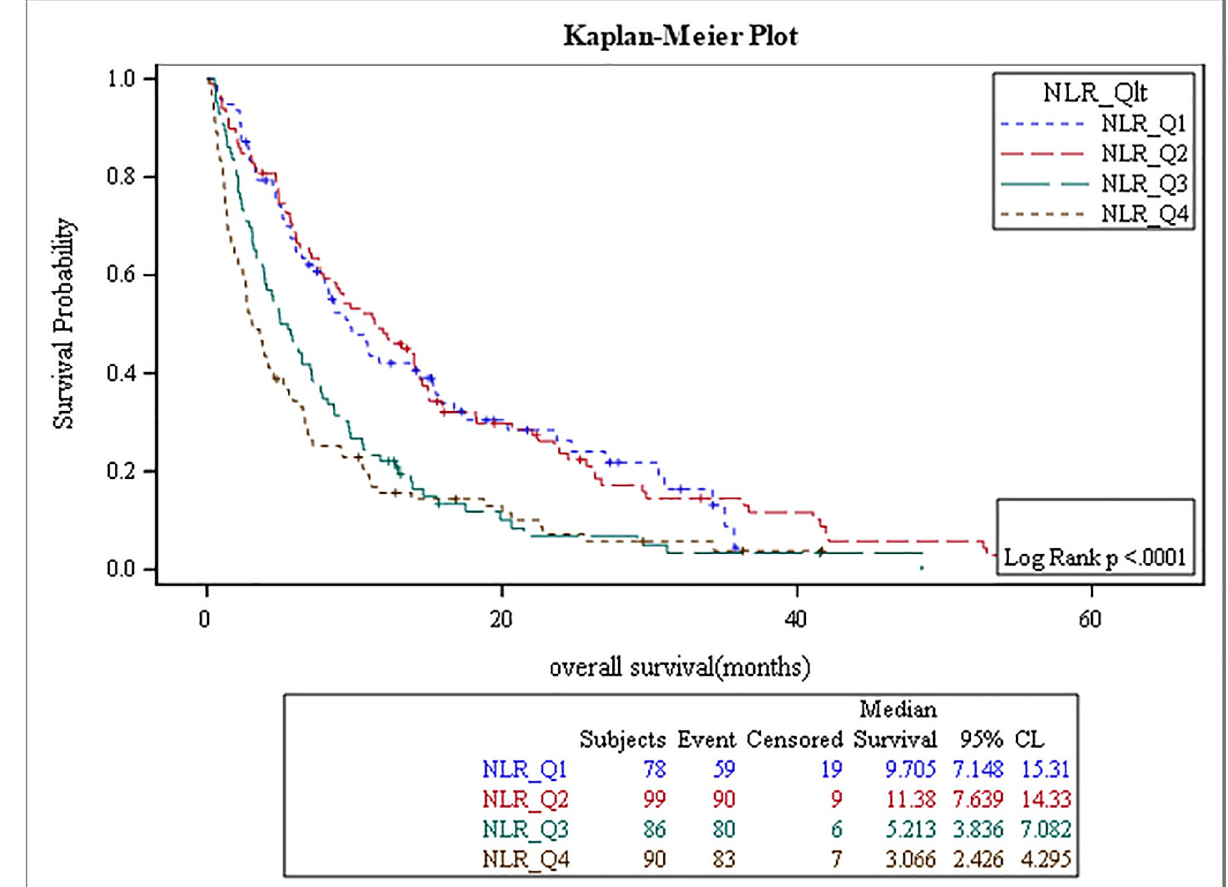
Fig 6. Kaplan Meier curve for overall survival for patients with NLR as categorical